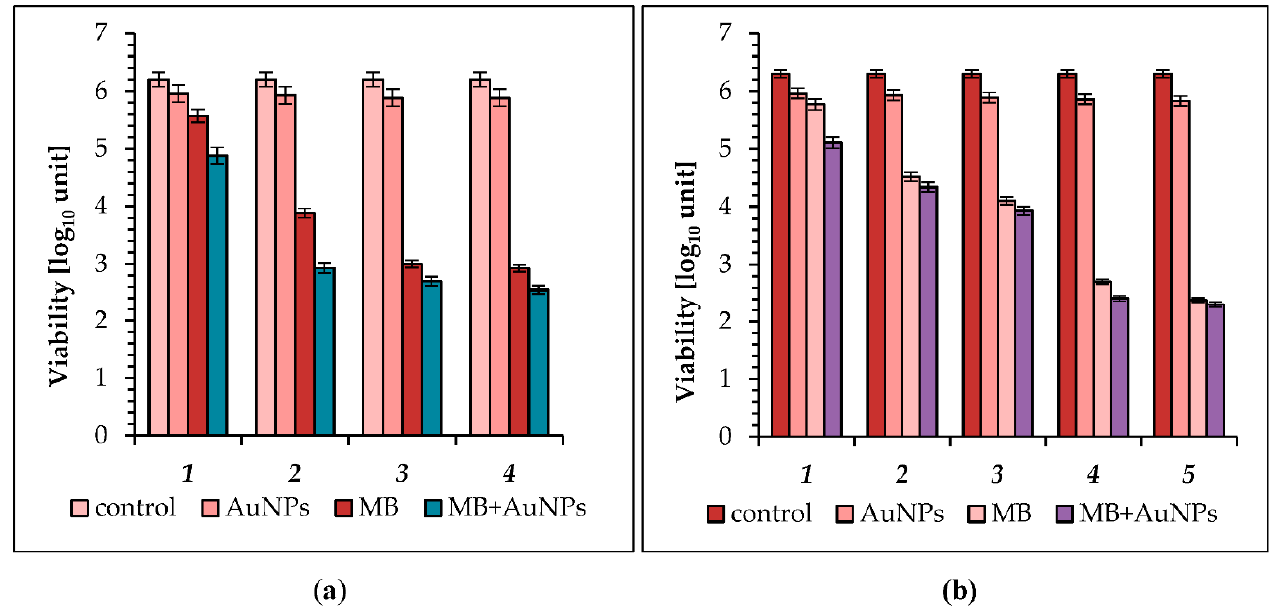
Figure 3. ( a ) Effect of AuNPs (gold nanoparticles), MB (methylene blue) and the MB + AuNP (methylene blue-gold nano- particle mixture) on viability of: S. aureus following incubation in the dark: ( 1 ) exposure to LED light for 5 min (energy fluence was 1.5 J cm − 2 ); ( 2 ) 15 min (energy fluence was 4.5 J cm − 2 ); ( 3 ) 30 min (energy fluence was 9 J cm − 2 ); ( 4 ) and 45 min (energy fluence was 13.5 J cm − 2 ). ( b ) E. coli following incubation in the dark: ( 1 ) exposure to LED light for 5 min (energy fluence was 1.5 J cm − 2 ); ( 2 ) 15 min (energy fluence was 4.5 J cm − 2 ); ( 3 ) 30 min (energy fluence was 9 J cm − 2 ); ( 4 ) 45 min (energy fluence was 13.5 J cm − 2 ); and ( 5 ) 60 min (energy fluence was 18 J cm − 2 ); (in all groups p < 0.05); the control is the initial concentration of bacteria in suspensions kept in the dark.